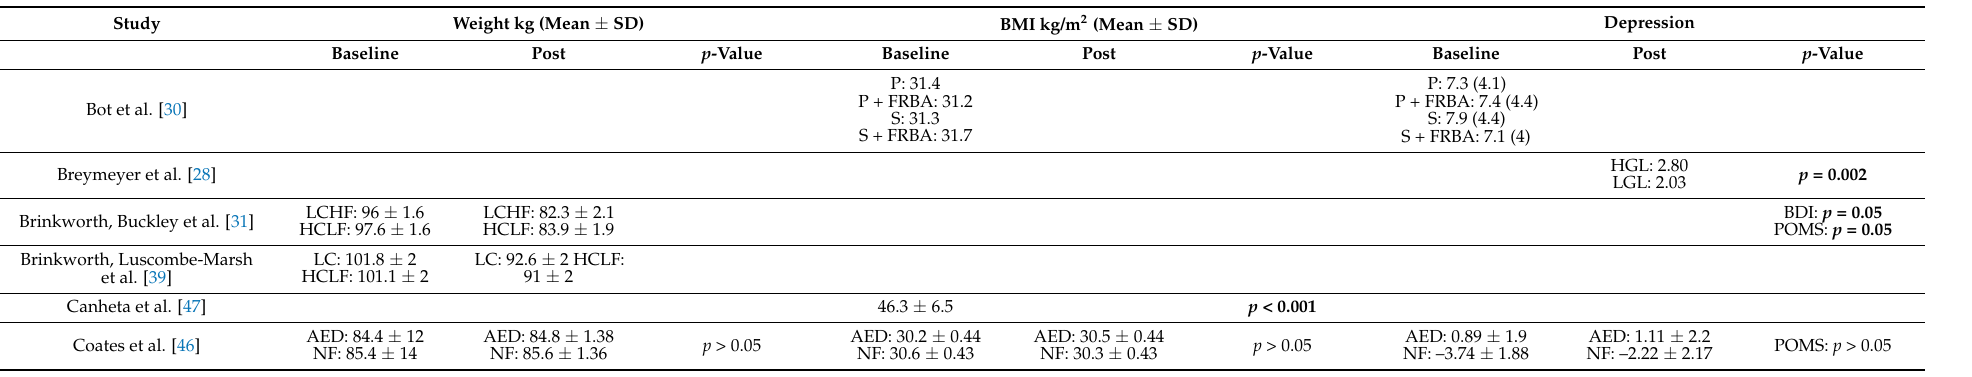
Table 2. Findings of included